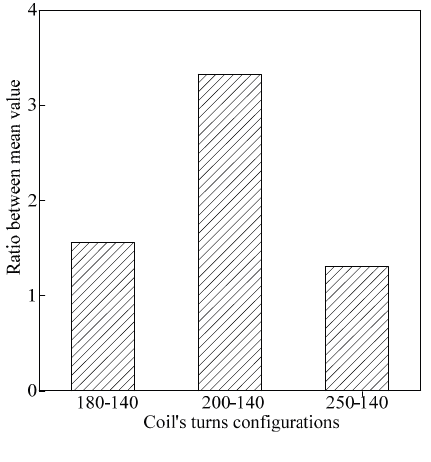
and and ratio between δ unripe and δ ripe for Nf Nf rr 2_1 ur 2_1